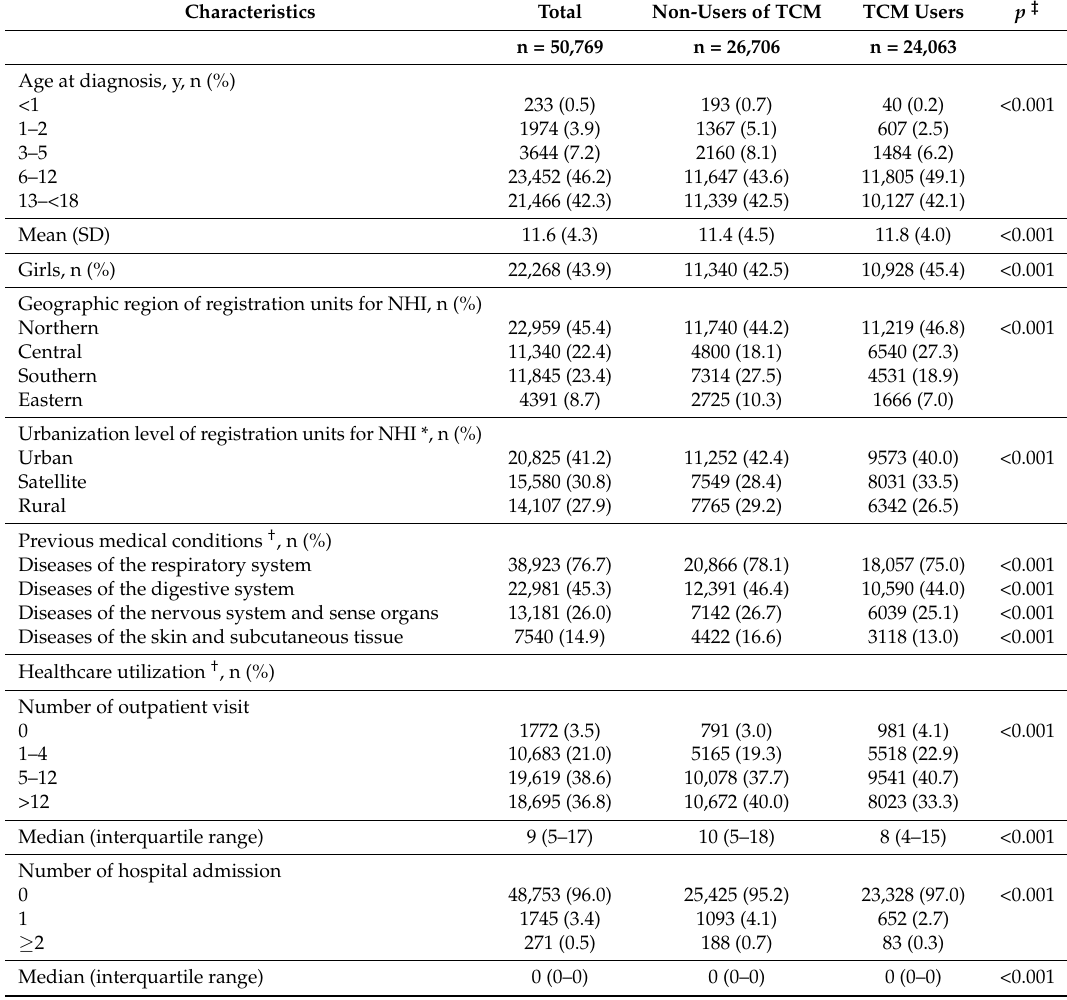
Table 1. Baseline characteristics of patients with dislocations, sprains and strains who did and did not use traditional Chinese medical care as the first option for consultation at their